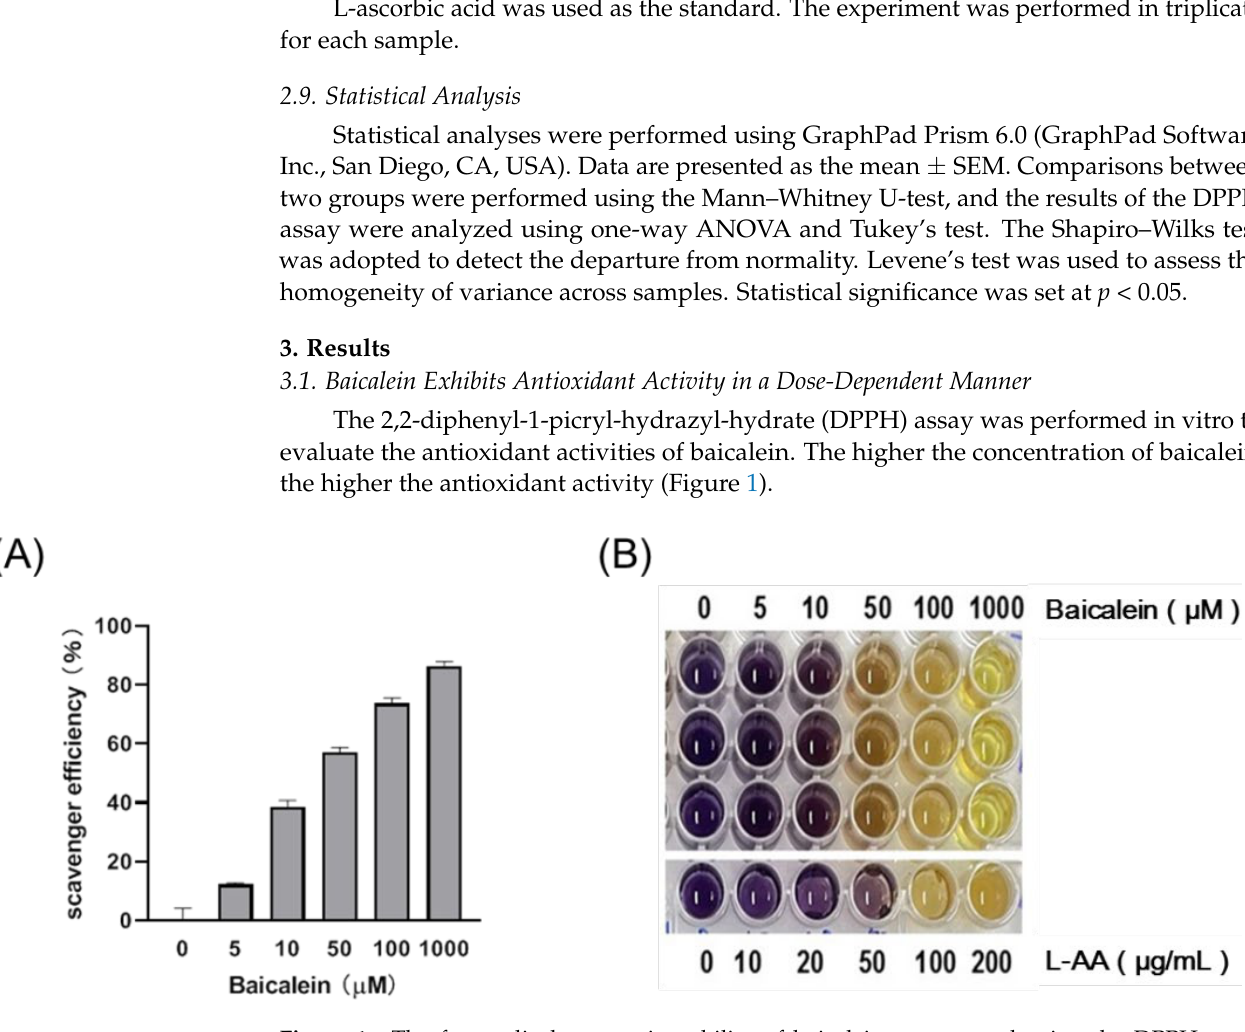
Figure 1. The free radical scavenging ability of baicalein, as assessed using the DPPH assay. ( A ) Baicalein scavenges free radicals in a dose-dependent manner. ( B ) The results of the DPPH assay. 3.2. Baicalein Effectively Relieves LPS-Induced Damage in Liver Macrophages According to our results, baicalein increased the viability of the macrophages alone and demonstrated effects against LPS at concentrations ranging from 1–10 µ M (Figure